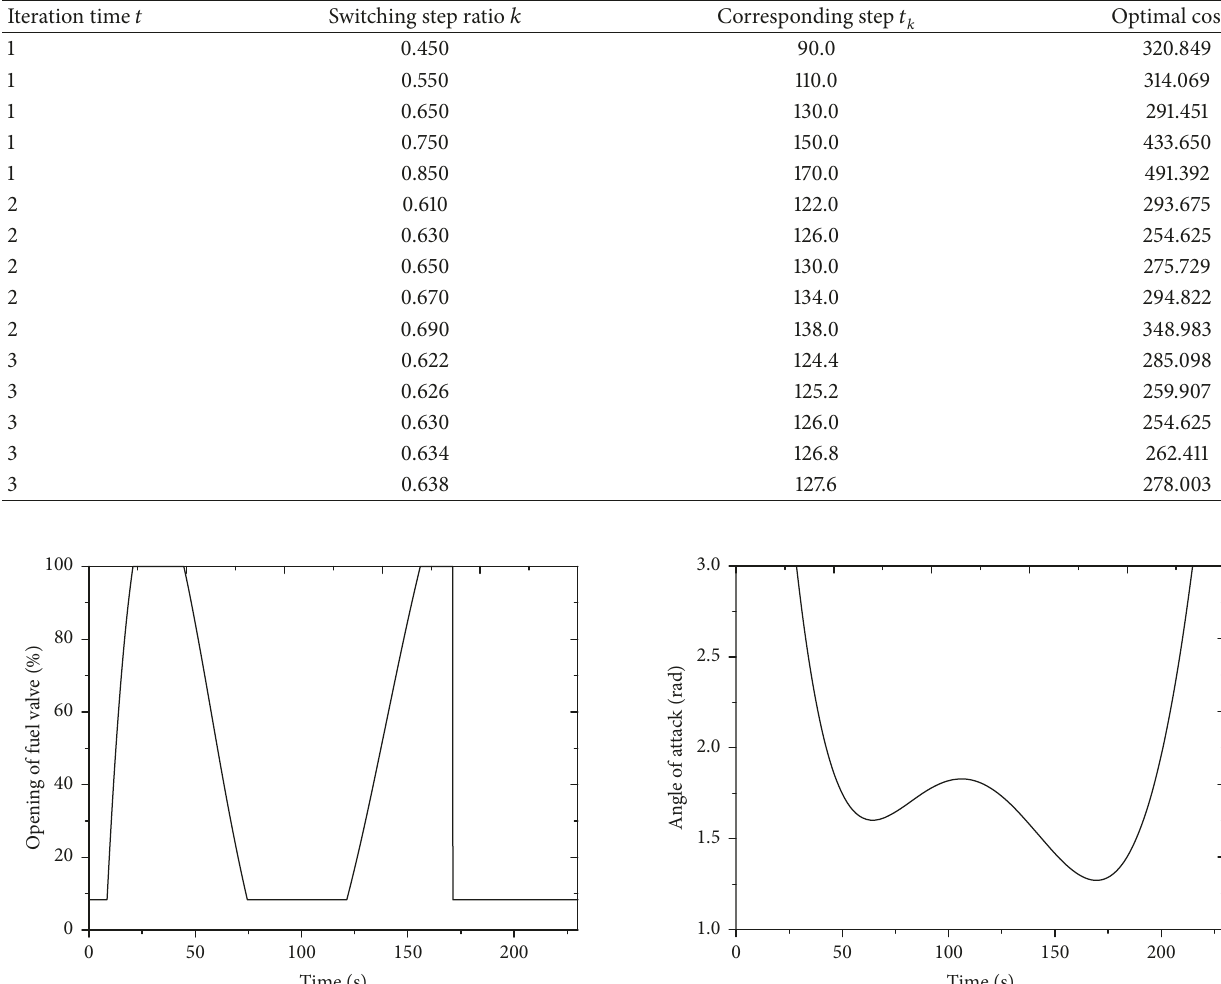
Table 1: Results after 1 time numerical simulation.